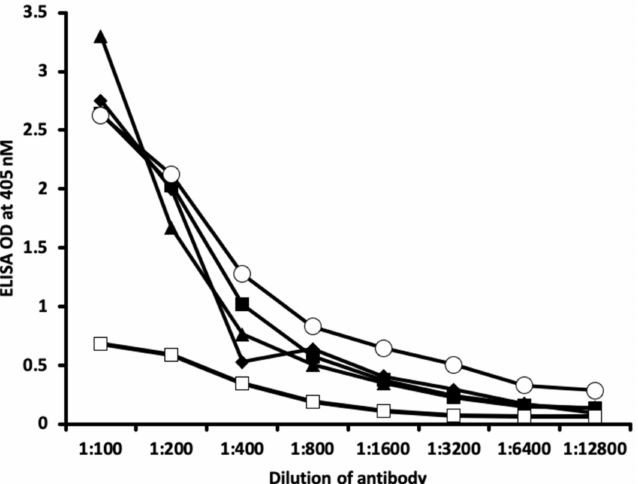
Figure 6. Reaction of di ff erent dilutions of thyroid antibodies with the same concentration of haptenic chemical-coated plates. Note that in proportion to the antibody dilution, a significant decline in the reaction of the antibodies to the haptenic chemicals was observed. (cid:7) = triiodothyronine antibody to protein disulfide isomerase (PDI); (cid:4) = triiodothyronine antibody to parabens-HSA; (cid:78) = triiodothyronine = thyroglobulin antibody to aflatoxin-HSA; (cid:3) = thyroid peroxidase antibody to aflatoxin-HSA; (cid:35) antibody to